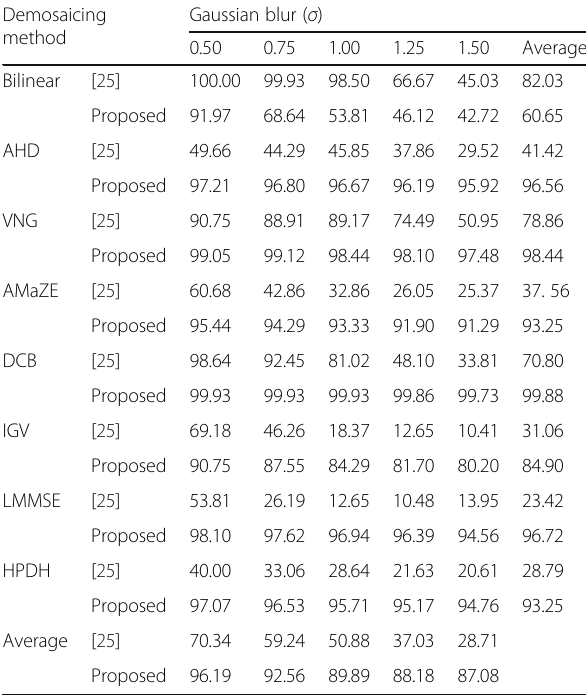
Table 6 Estimation accuracy comparison between conventional algorithm and proposed method with Gaussian blur for different demosaicing methods (unit: %). Block size fixed to 256 × 256